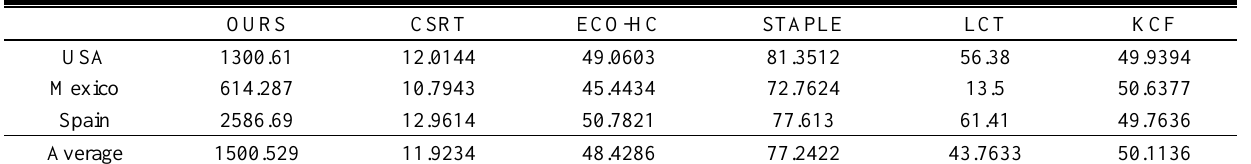
Table I AVERAGE SPEED( IN FPS UNITS